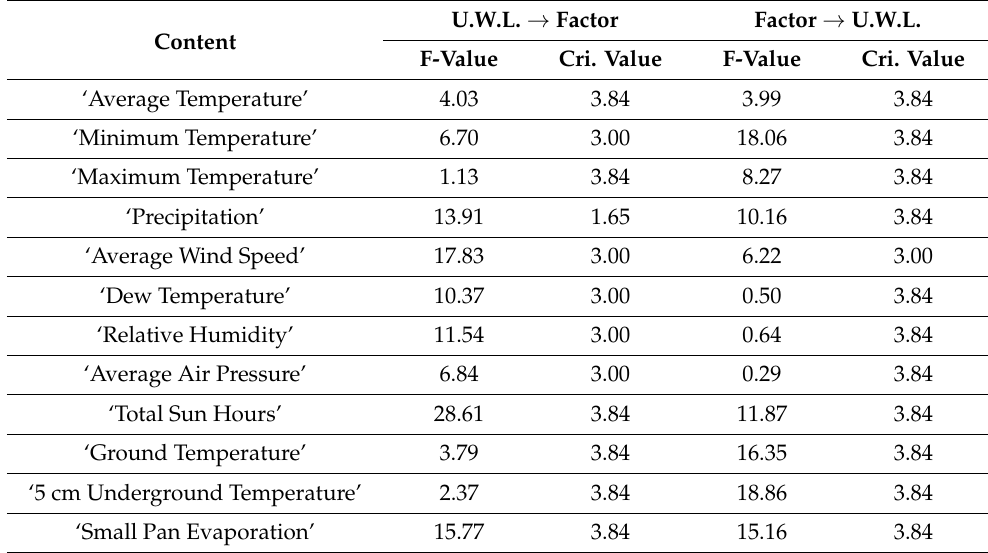
Figure 4. Cross-wavelet result between groundwater level and each meteorological factor: ( a ) average temperature; ( b ) minimum temperature; ( c ) maximum temperature, ( d ) precipitation; ( e ) average wind speed; ( f ) dew temperature; ( g ) relative humidity; ( h ) average air pressure; ( i ) total sunshine hours; ( j ) ground temperature; ( k ) 5 cm underground temperature; ( l ) small pan evaporation. Bold-lined area indicates that there are correlations with groundwater level. Table 1. Granger’s causality test between groundwater level and each meteorological factor.